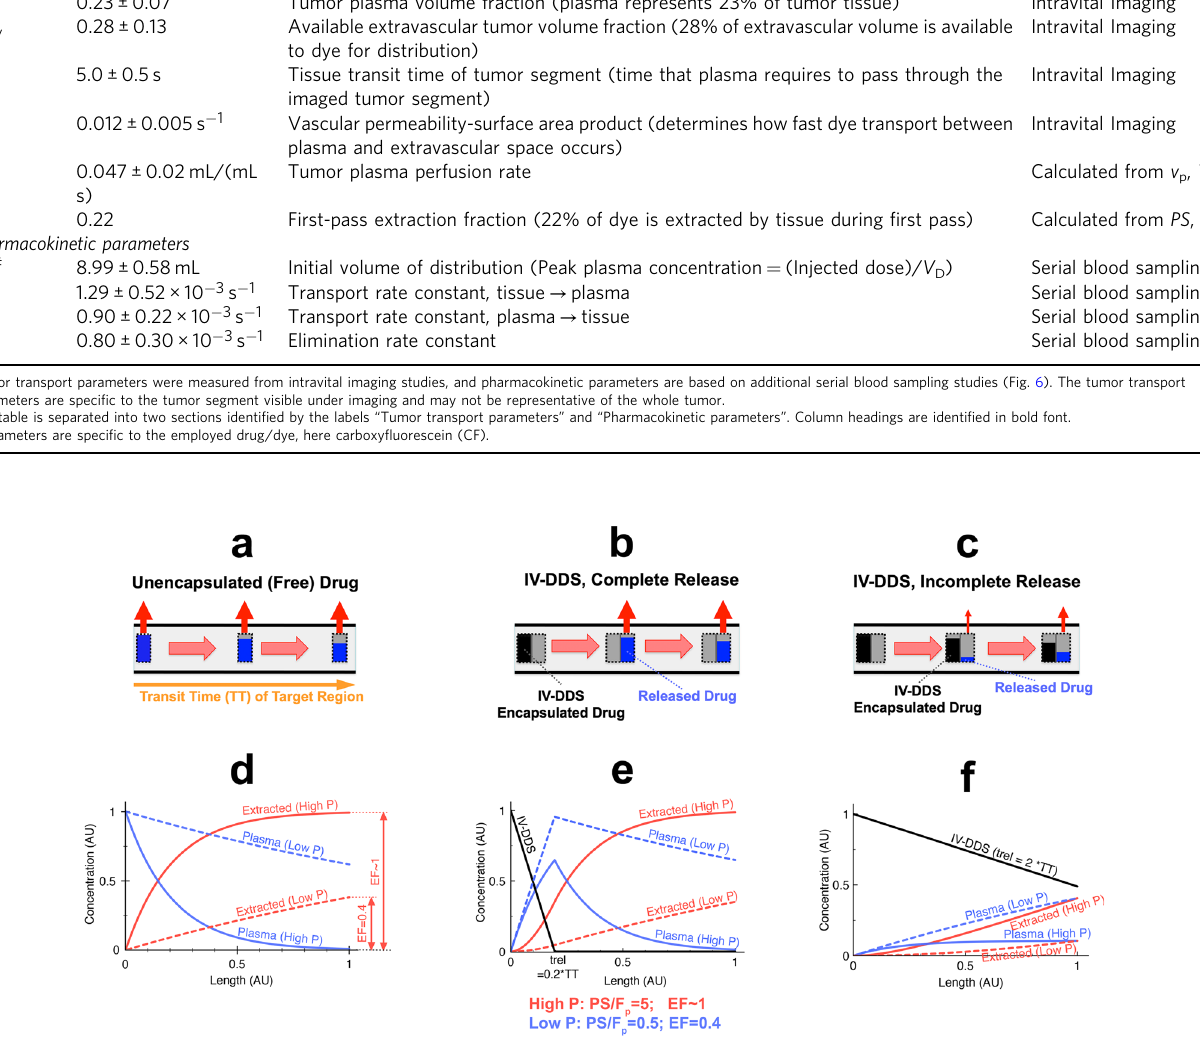
Fig. 3 Schematic of microvascular concentration gradient. Plasma traverses the microvasculature between supplying artery and draining vein of the target tissue segment. Plasma concentration of unencapsulated/released drug (blue bar), and IV-DDS-encapsulated drug (black bar) are shown, with red arrows indicating tissue drug uptake (transvascular transport into interstitium/EES). Three cases are presented: a Unencapsulated drug infusion, b IV-DDS with complete release during transit ( t rel << TT ), and c IV-DDS with incomplete release ( t rel >> TT ). d – f For each case ( a – c ), the corresponding longitudinal concentration gradients along microvasculature length are shown based on computer models: free drug plasma concentration (blue), cumulative extracted amount by tissue (red), and IV-DDS-encapsulated drug plasma concentration (black). Both a drug with high permeability that is rapidly extracted ( “ High P ” , solid lines; PS / F p = 5; EF ~1), and a drug with lower permeability and slow extraction ( “ Low P ” , dashed lines; PS / F p = 0.5; EF = 0.4) are presented. Note that all fi gures show the fi rst pass where no drug has yet been extracted (i.e. interstitial/EES concentration is turn depends on plasma perfusion ( F p [1/s]), vascular drug per- kinetics of IV-DDS . In traditional chemotherapy, drug is administered as a bioavailable ( “ free ” ) agent, and the drug is extracted by tissue (transvascular transport into extravascular space) as the drug passes through the microvasculature of both targeted and untargeted tissue regions (Fig. 3a). The amount of The latter two parameters are often combined as “ vascular drug extracted by tissue depends on vascular drug permeability permeability-surface area product ” ( PS [1/s]), and we experimen- and perfusion, where in the case of high permeability (solid tally measured (via intravital microscopy) and used this curves in Fig. 3d), complete extraction of the drug may occur. The parameter product in our computer model. The case of complete extent of drug extraction is often quanti fi ed by the parameter extraction ( EF ~ 1, equivalent to F p << PS ) is commonly termed “ fi rst-pass extraction fraction (or extraction ratio) ” ( EF ), which in “ perfusion-limited transport ” since tissue drug uptake is limited